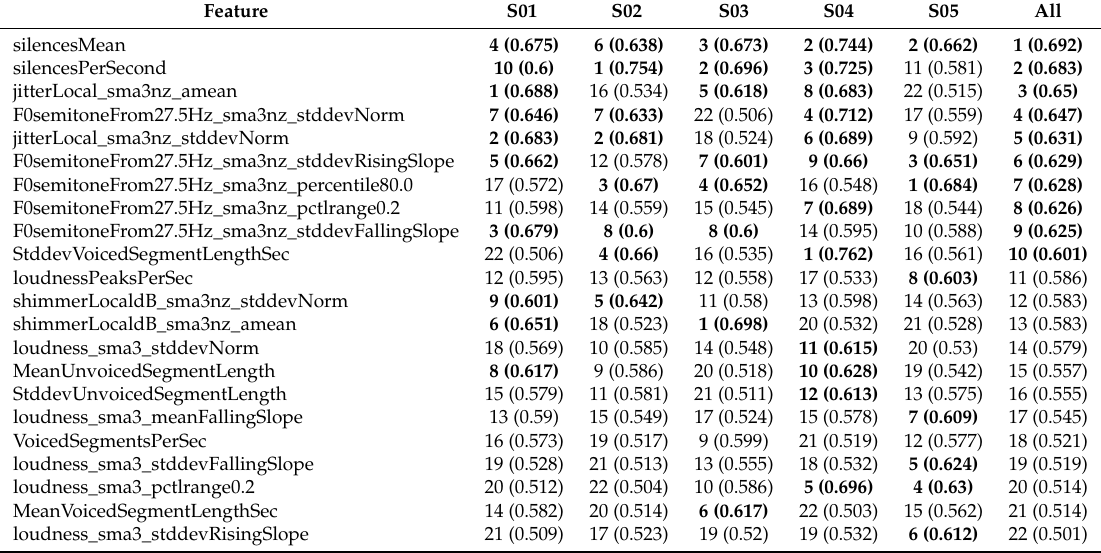
Table 4. Ranking of the correlated prosodic features (frequency, energy and temporal) between each C1 speaker and the expert evaluation. The first number represents the order of each feature in the ranking and the second number shows the area under the ROC curve. These values were calculated using an SVM classifier. The features are sorted by their importance when all data are used. Values in bold represent an area under the ROC curve above